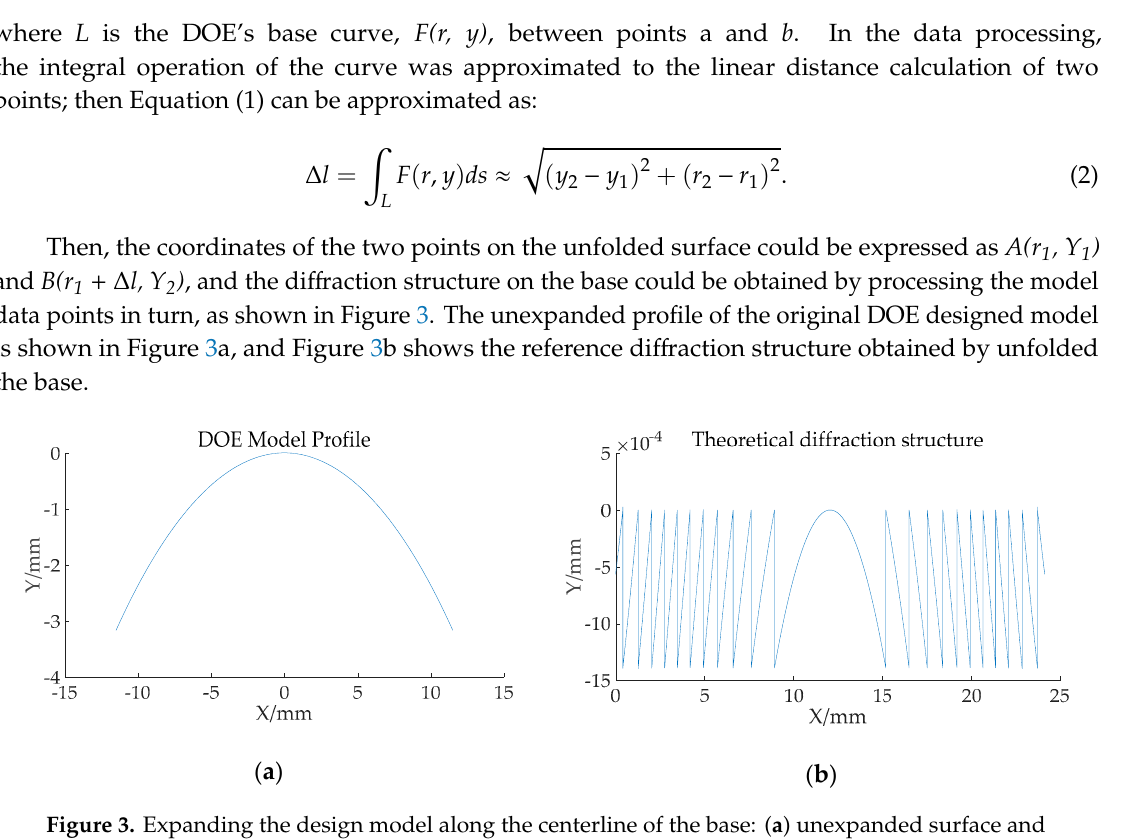
Figure 3. Expanding the design model along the centerline of the base: ( a ) unexpanded surface and ( b ) unfolded surface.